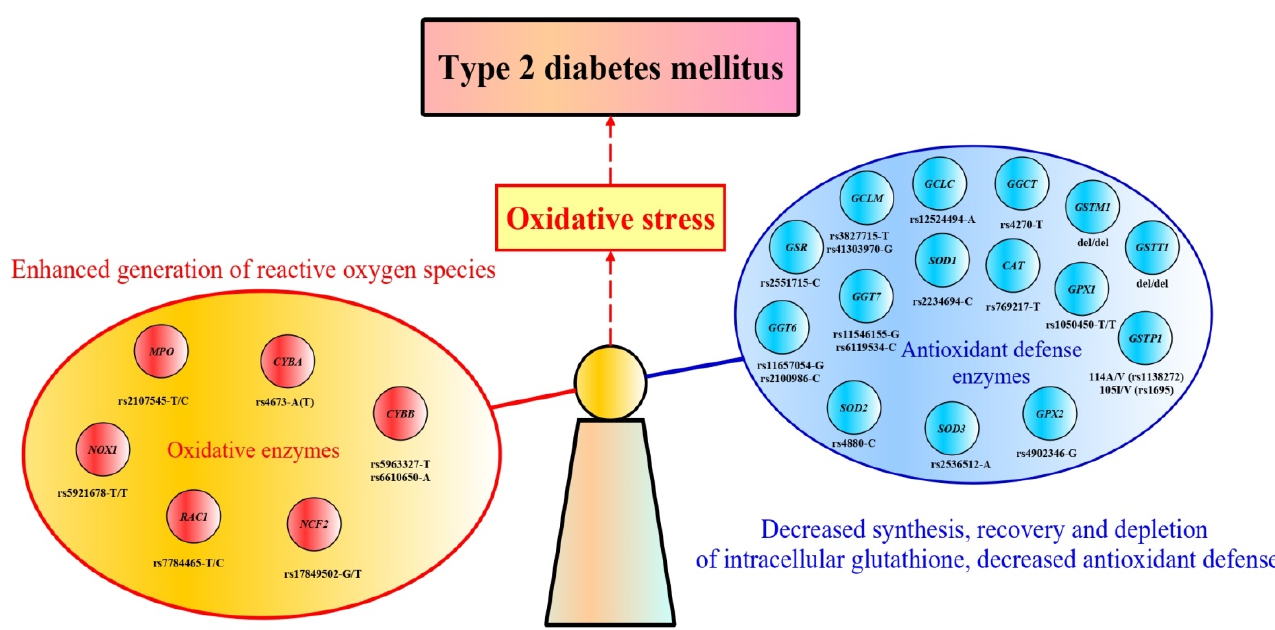
Figure 1. The relationship between genes encoding enzymes involved in the regulation of redox homeostasis and the development of type 2 diabetes. The scheme reflects the genetic causes respon‑ sible for oxidative stress in type 2 diabetes as a result of an imbalance between the generation of free radicals and their neutralization, which is attributed to the impact of polymorphisms in the genes encoding oxidative and antioxidant defense enzymes. Genotypes and alleles of the increased disease risk are shown along the genes. GSTM1, glutathione S‑transferase M1; GSTT1,